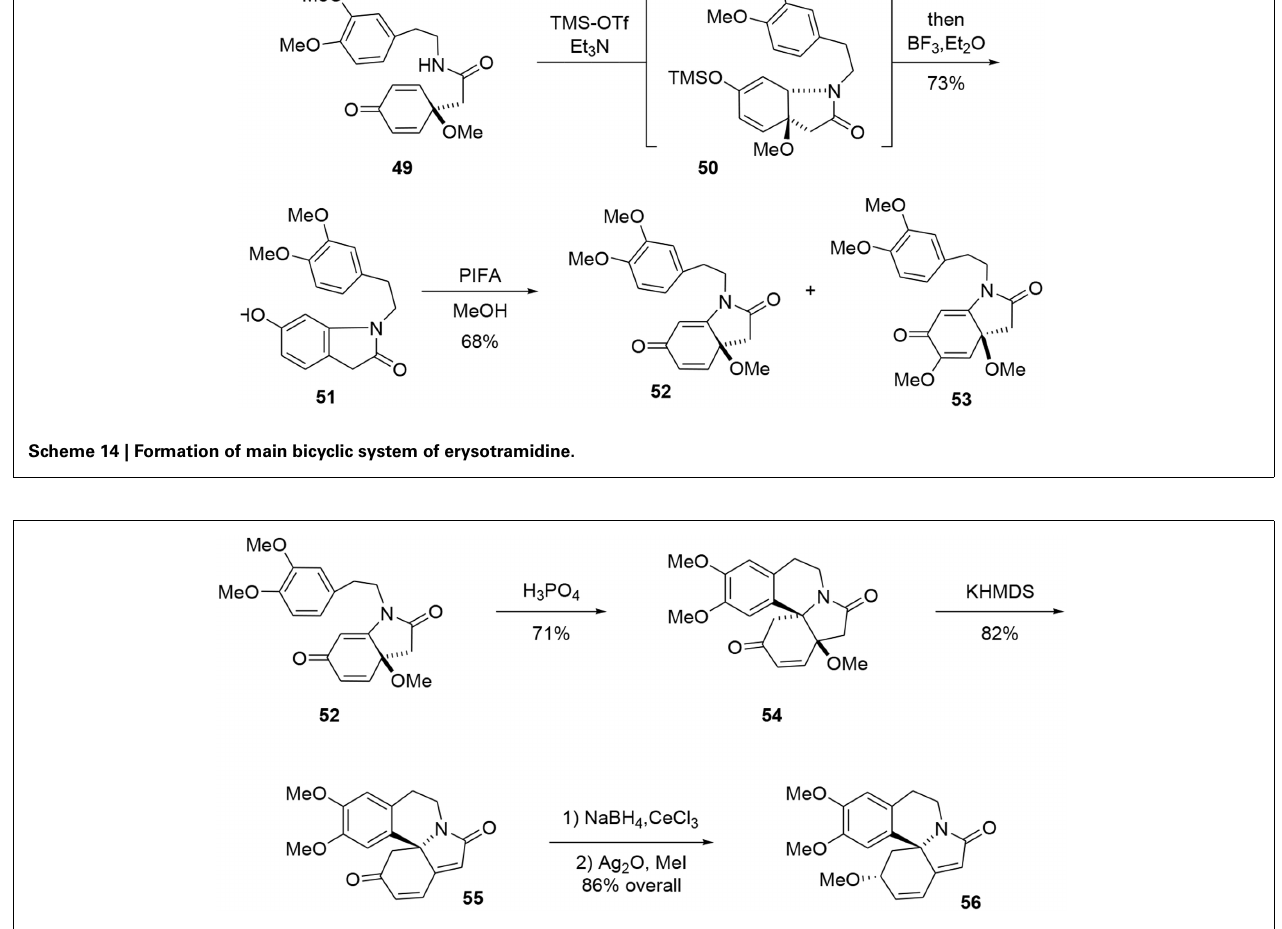
Scheme 15 | Final steps of erysotramidine